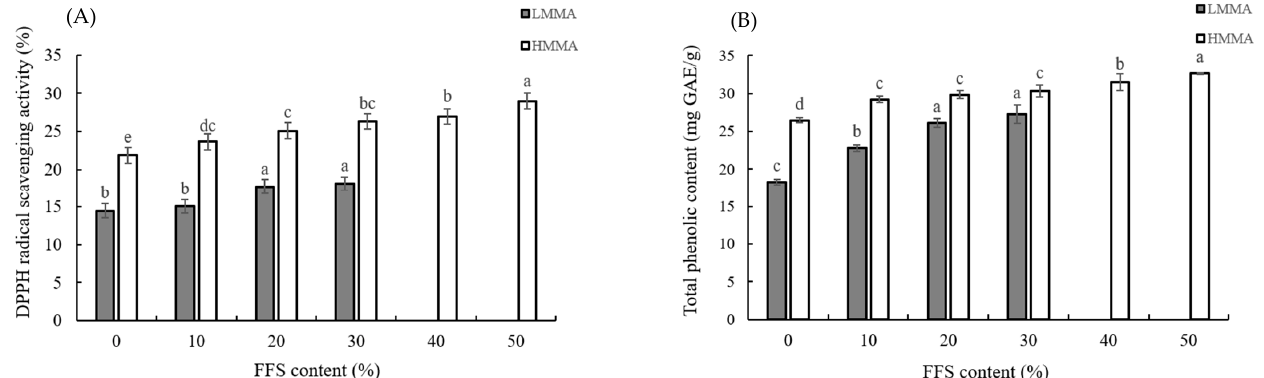
Figure 4. DPPH free radical scavenging activity ( A ) and total phenolic contents ( B ) of meat analogs with various by full-fat soy (FFS) contents. LMMA: low-moisture meat analog; HMMA: high-moisture meat analog. Different letters (a–e) above the bars indicate the significantly different for each extrusion type (LMMA and HMMA) ( p ≤ 0.05) by Duncan’s multiple range tests.